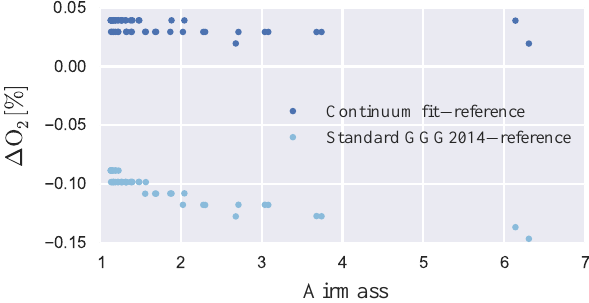
Figure 5. Air-mass dependence for the O 2 (cw: 7885.0) spectral window retrieved by the standard GGG2014 TCCON retrieval strat- egy and using a higher-order continuum fit. As a reference, cavity- ratioed atmospheric spectra are used for the standard GGG2014 re- trieval